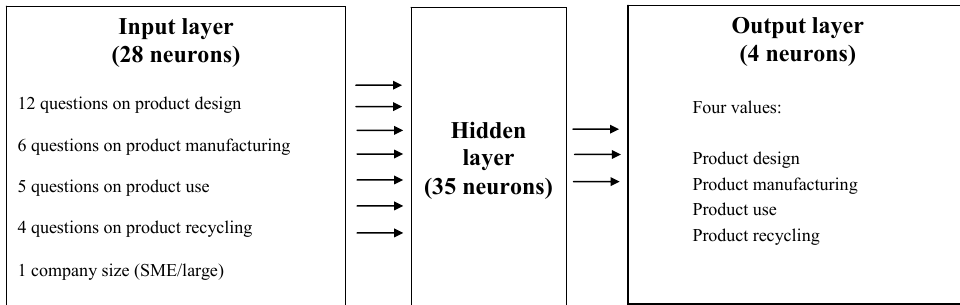
Figure 1. Artificial neural network (ANN) structure: inputs and outputs.